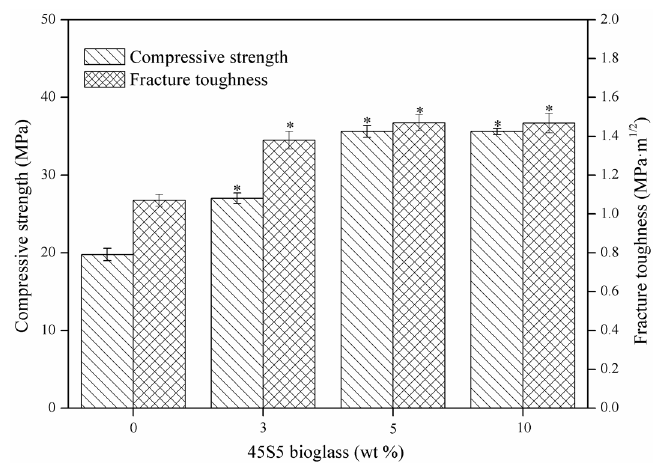
Figure 4. Compressive strength and fracture toughness of CaSO 4 scaffolds with different amounts of 45S5 bioglass. Statistically significant difference (* p < 0.05) from scaffolds without bioglass.